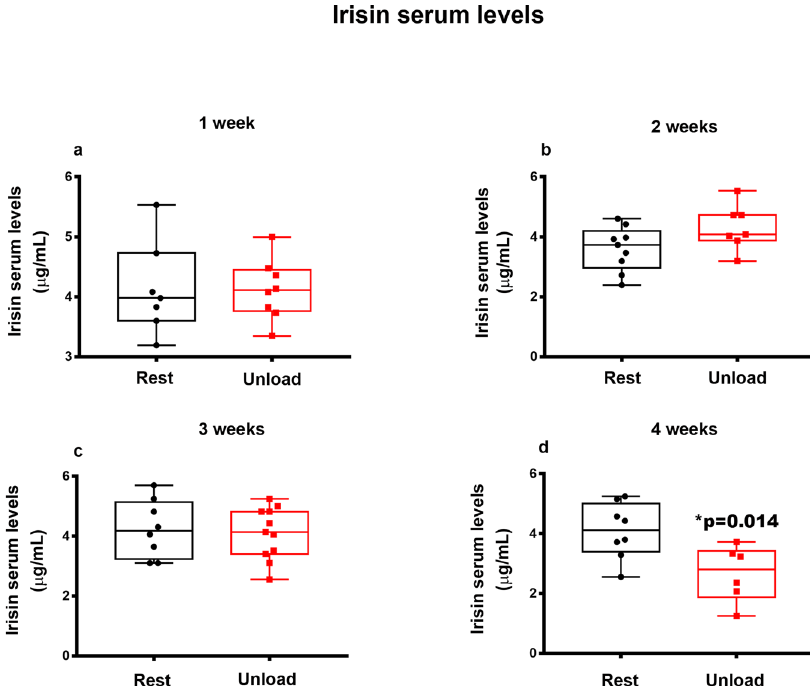
Fig. 6 Effect of unloading on irisin serum levels. Figure 6 showed the trend in irisin serum levels of control mice kept in resting condition (Rest) and HU mice (Unload) for 1-2-3 and 4 weeks ( a – d ). Irisin serum levels were signi fi cantly reduced after 4 weeks of unloading compared to Rest mice ( d ). Shapiro-Wilk test and Mann-Whitney test were performed. Data are presented as box-and-whisker with median and interquartile ranges, from max to min, with all data points shown. * p < 0.05 vs